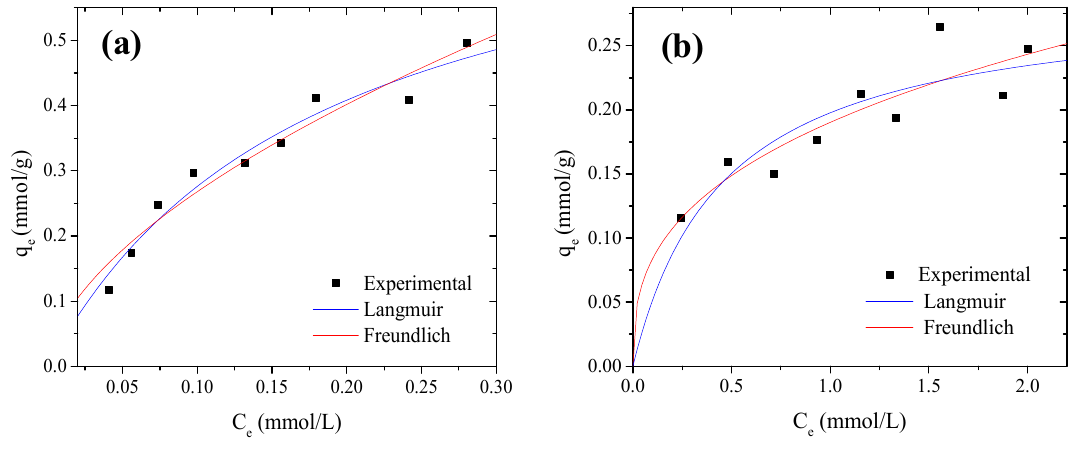
mum adsorption capacity obtained for MB and Cd 2+ using OP without any treatment vs. adsorption capacities using different adsorbents obtained by transformation of OP.